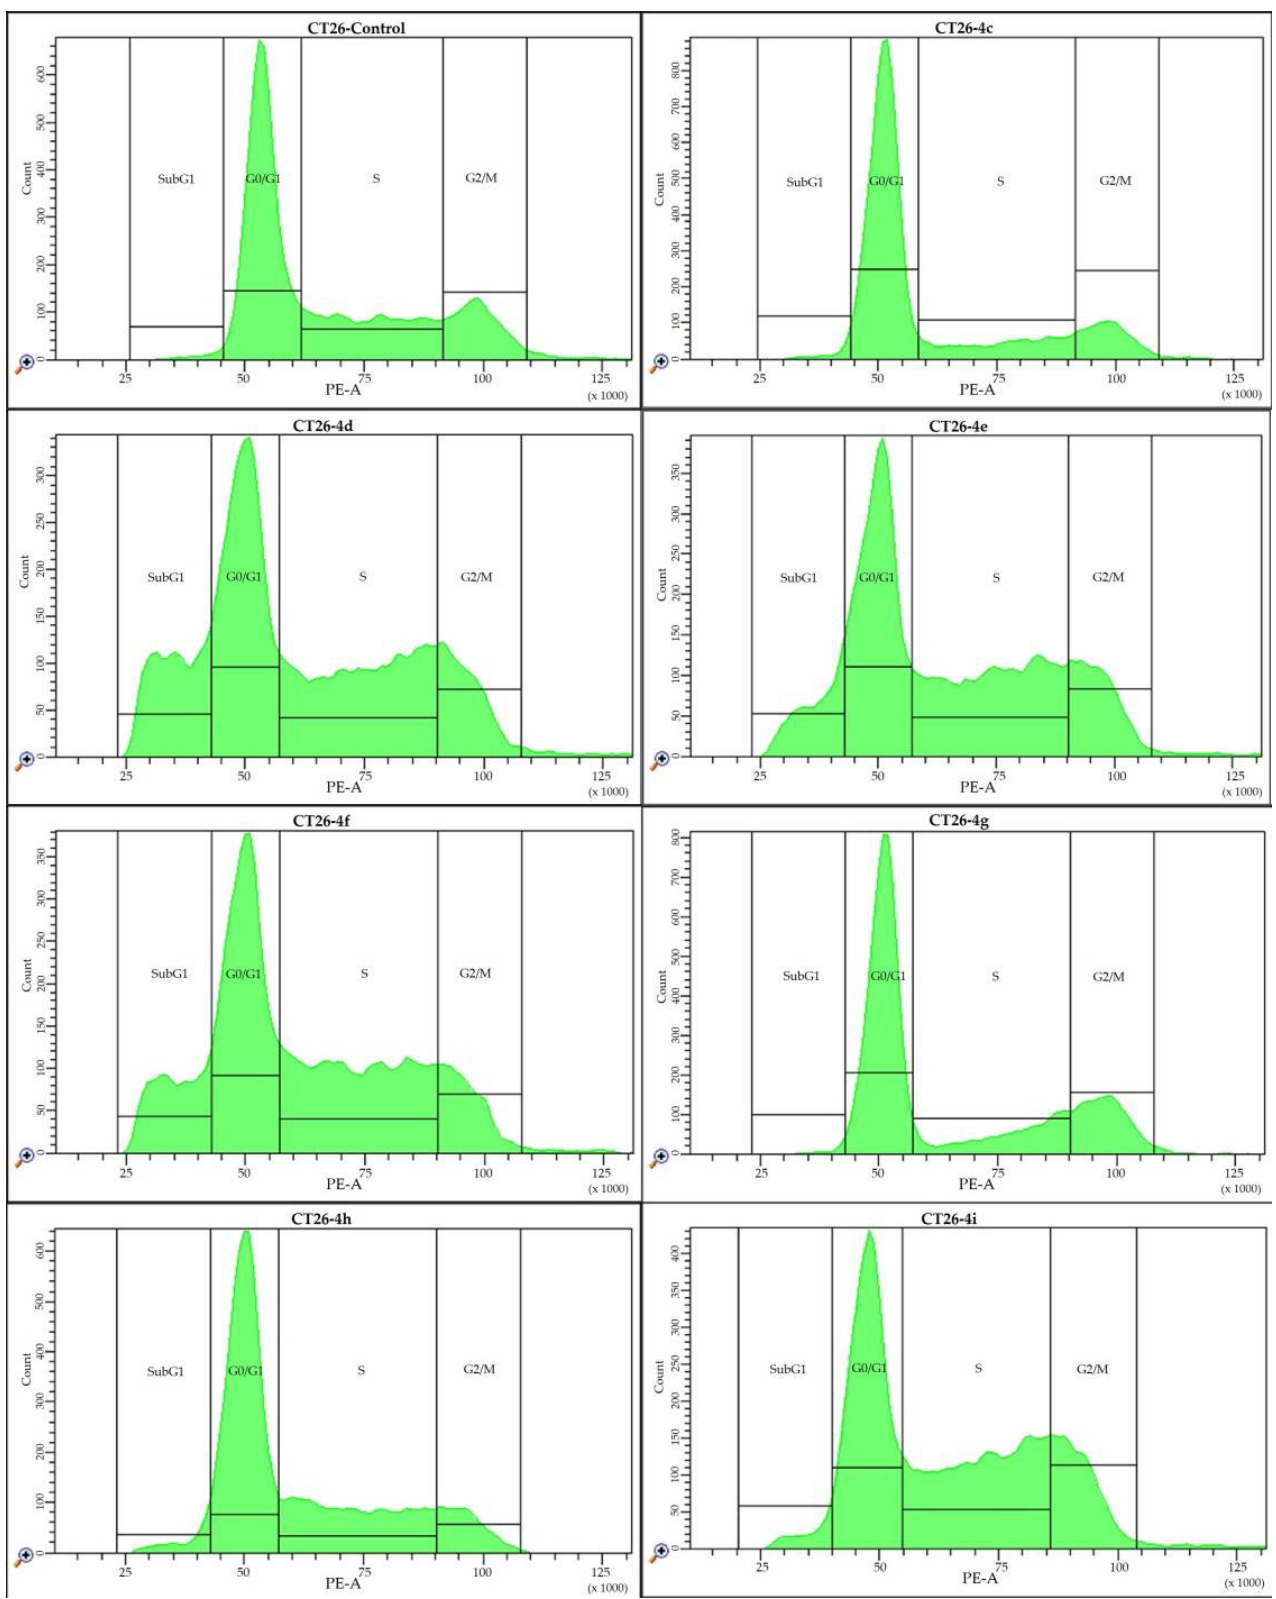
Figure 9. Effect of cycloadducts 4c–i at concentration 10 μg/mL on the distribution of CT26 cells in the cell cycle.